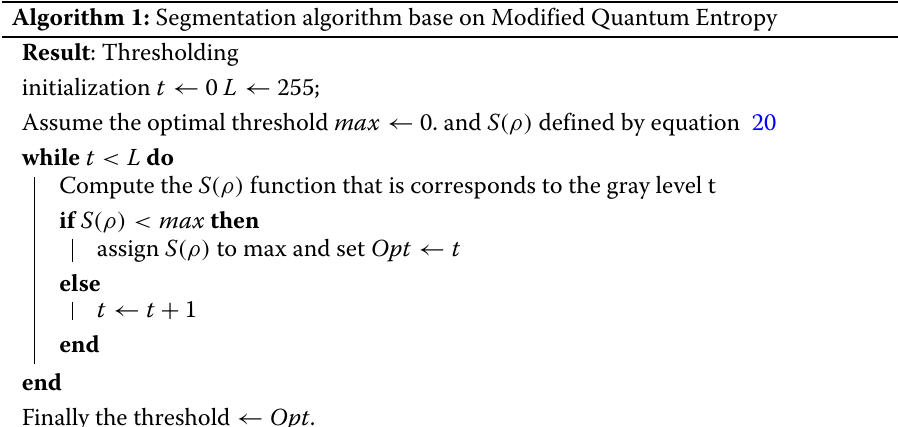
Algorithm 1: Segmentation algorithm base on Modified Quantum